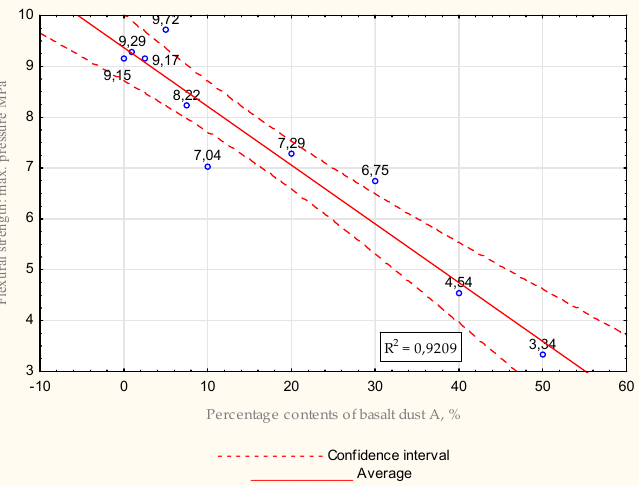
Figure 20. Average values received during flexural strength tests for water − mix ratio = 0.6.